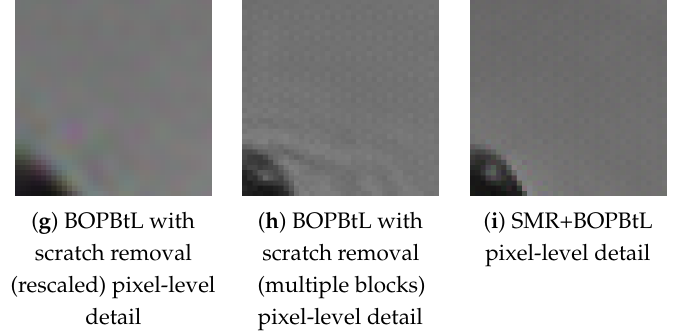
Figure 9. Results of BOPBtL with scratch removal or in combination with SMR+ on the same stereo pair of Figure 1. Notice that the visual pleasant results of ( a ) are due to the frequency cutoff caused by rescaling and disappear at a larger viewing scale such in ( d ). Best viewed in color. The reader is invited to zoom in on the electronic version of the manuscript in order to better appreciate the visual